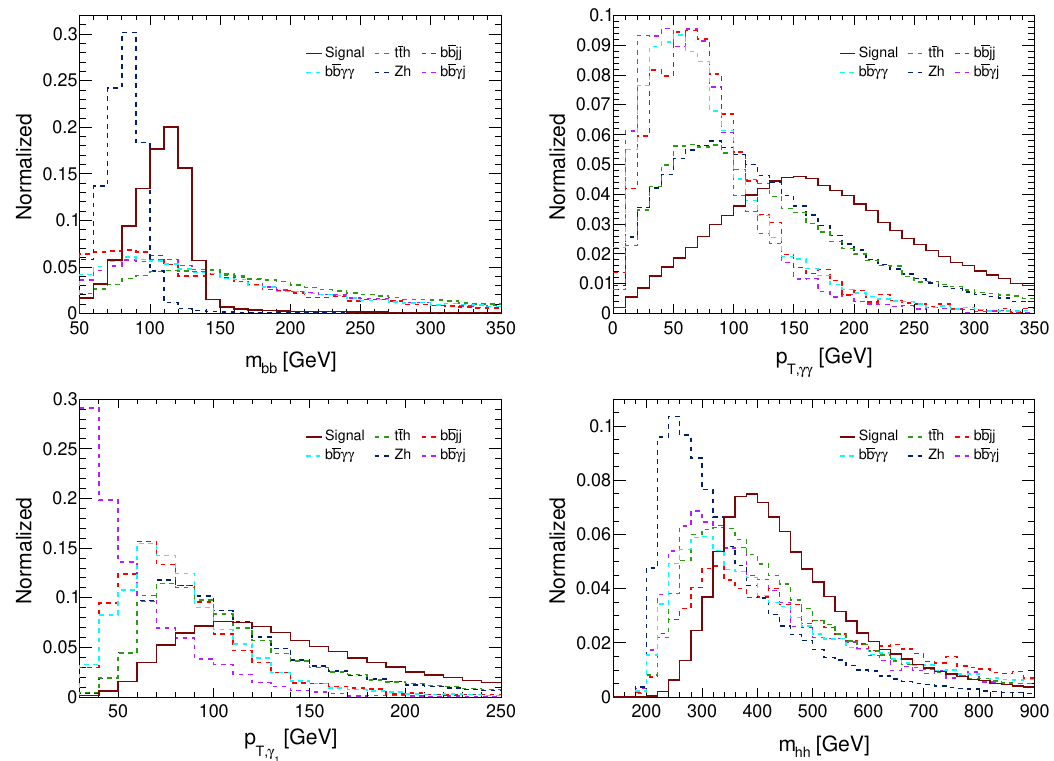
Figure 1 . Normalized distributions of m bb , p T,γγ , p T,γ and the dominant backgrounds after the acceptance cuts and the generation level